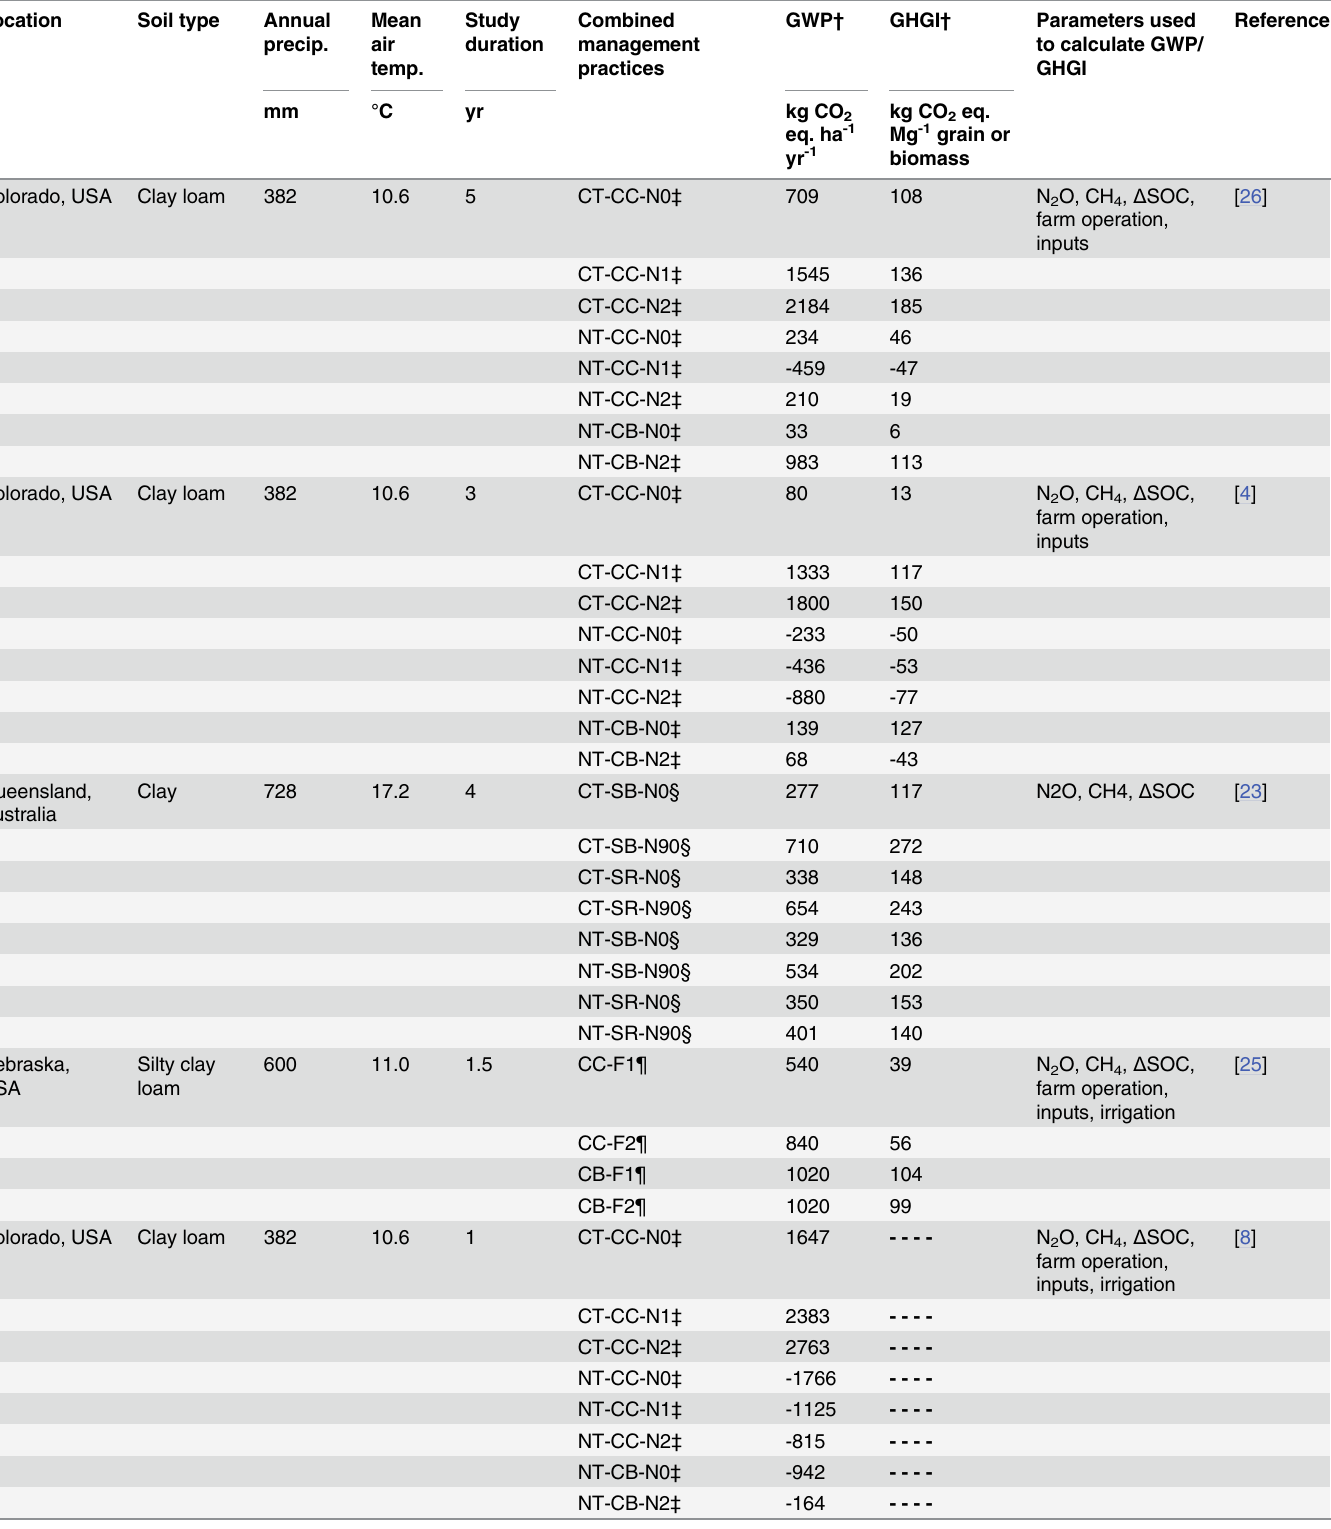
Table 4. Effect of combined management practices (tillage, cropping system, and N fertilization) on net global warming potential (GWP) and green- house gas intensity (GHGI) calculated by using the soil organic C method in various regions with different soil and climatic conditions.